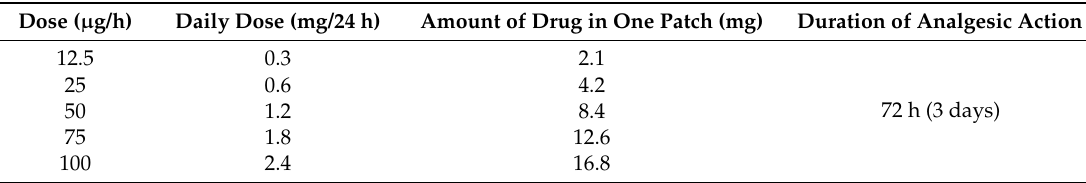
Table 2. Basic data of transdermal fentanyl